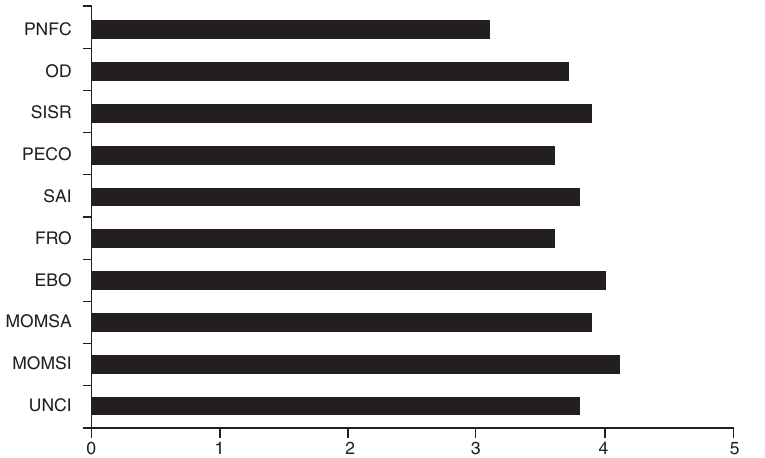
Figure 4 Mean grades attributed to the procedures. PNFC, pedicled nasoseptal flap creation; OD, orbital decompression; SISR, sphenoid intersinus septum resection; PECO, posterior ethmoidal cells opening; SAI, sphenopalatine artery identification; FRO, frontal recess opening; EBO, ethmoidal bulla opening; MOMSA, main ostium of maxillary sinus amplification; MOMSI, main ostium of maxillary sinus identification; UNCI, uncinectomy.